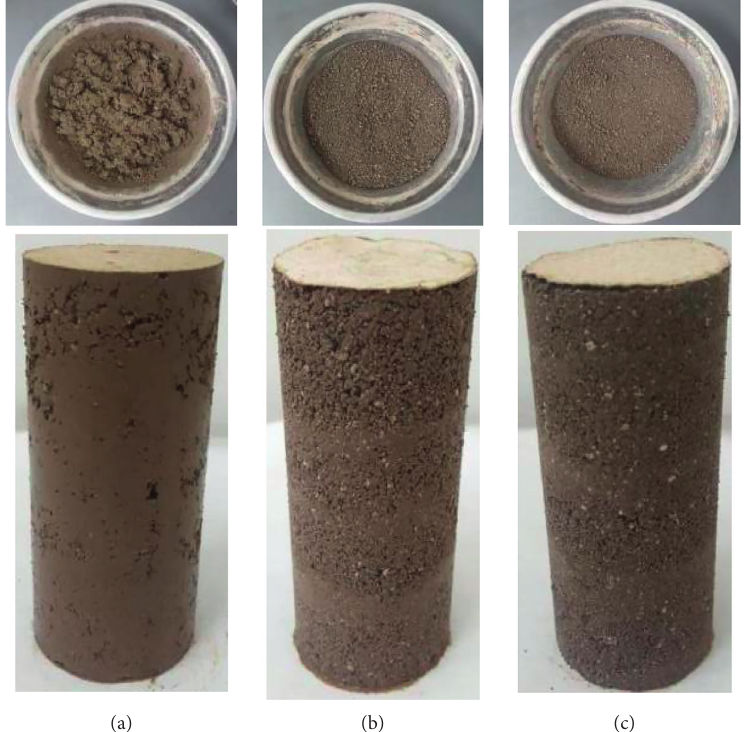
Figure 4: The triaxial mixture sample of different steel slag incorporation ( ω � 90%). (a) α